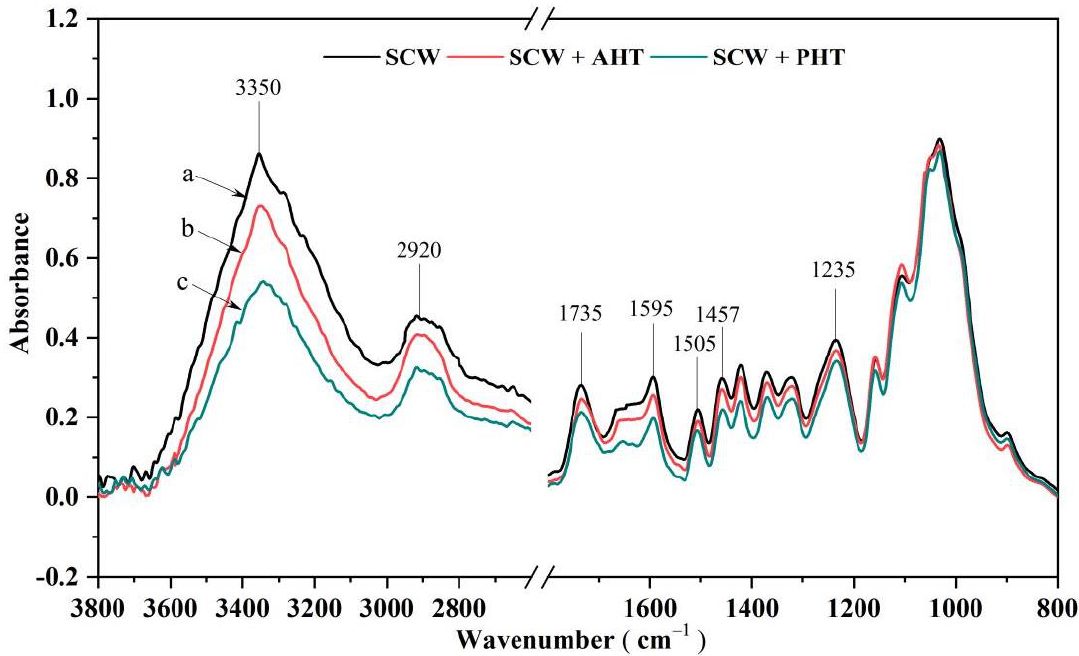
Figure 4. FTIR spectra of SCW (a), SCW + AHT (b), and SCW + PHT (c). SCW, surface-compressed wood without post-treatment; SCW + AHT, surface-compressed wood with atmospheric steam heat treatment; SCW + PHT, surface-compressed wood with pressurized steam heat treatment. The band at 1457 cm − 1 is attributed to CH 2 symmetric bending on the xylan ring